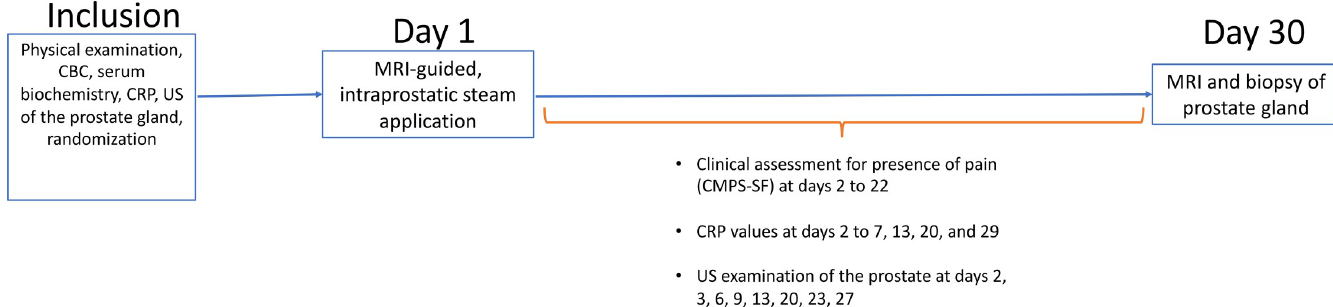
Fig 2. Study design. Abbreviations: CBC: complete blood count; CRP: c-reactive protein; US: ultrasound; MRI: magnetic resonance imaging; CMPS-SF: short form of the Glasgow composite measure pain scale.